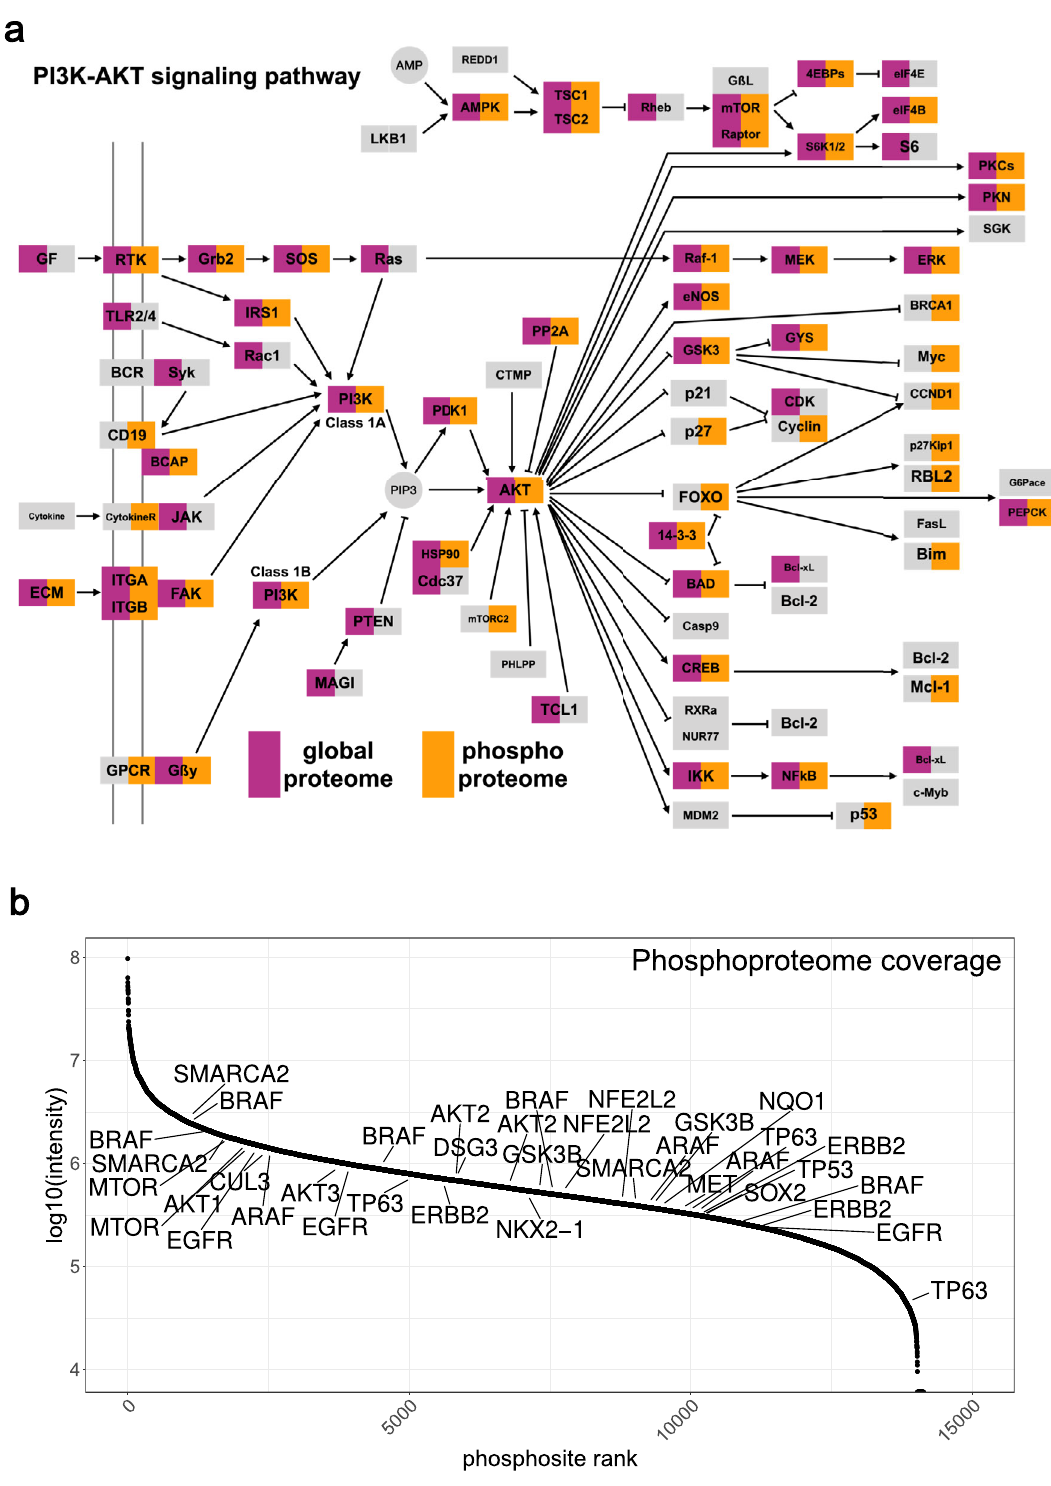
Fig. 3 Phosphoproteome analysis with equal loading TMT11 provides a comprehensive overview of cancer-relevant pathways. a Most key components of the PI3K-AKT signaling pathway were covered by equal loading TMT on a global proteome (shown in magenta) and phosphoproteome (shown in orange) level. PI3K-Akt signaling pathway was adapted from KEGG pathway hsa04151. b Log10 reporter ion intensity distribution over all phosphosites that were quanti fi ed in equal loading TMT. Lung cancer-relevant phosphoproteins are indicated by gene names. A coverage of 15,015 and 15,486 phosphosites was achieved for the two replicates (overlap of 14,133